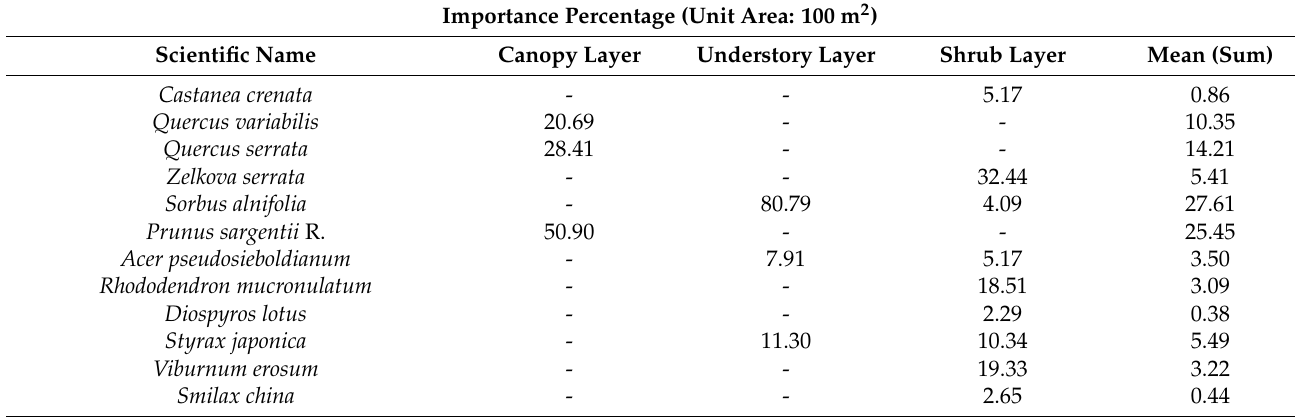
Table 8. Plant community structure of the Quercus serrata—Quercus mongolica community (survey plot no. 19) in the forest of the Changdeokgung Rear